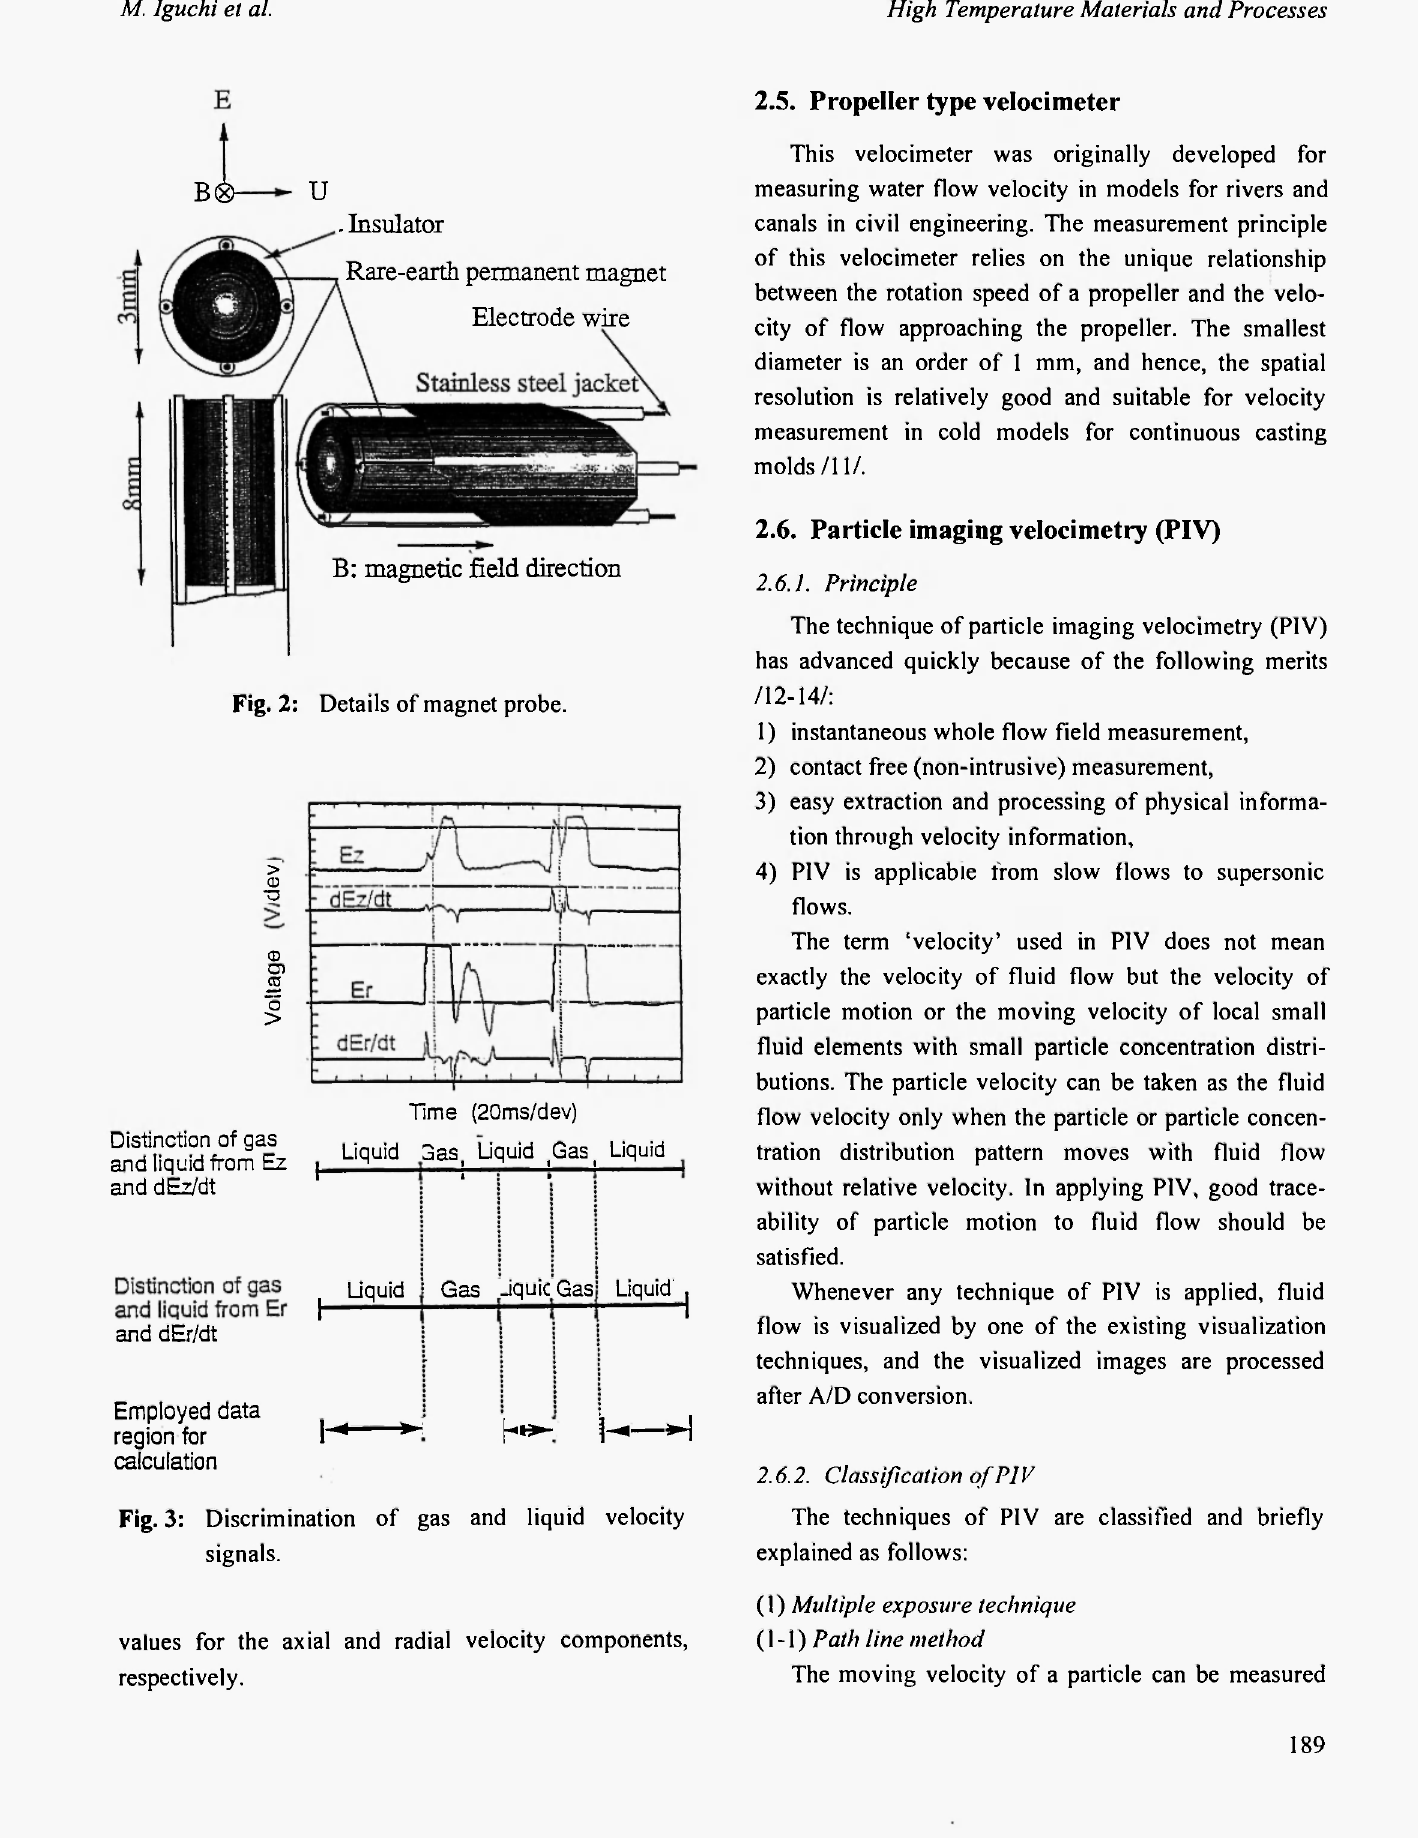
values for the axial and radial velocity components,